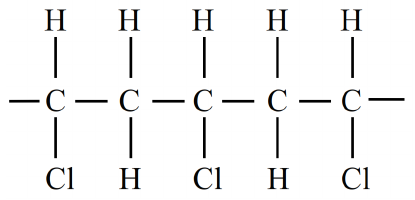
Figure 1. The molecular formula of polyvinyl chloride.